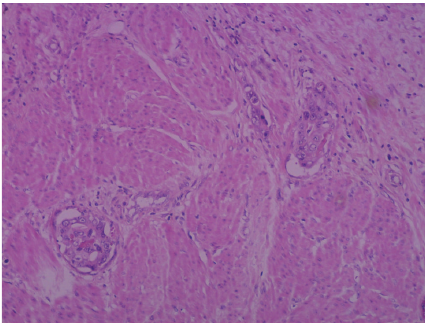
Figure 4: Irregular neoplastic glands infiltrating between the myometrial smooth muscle bundles.